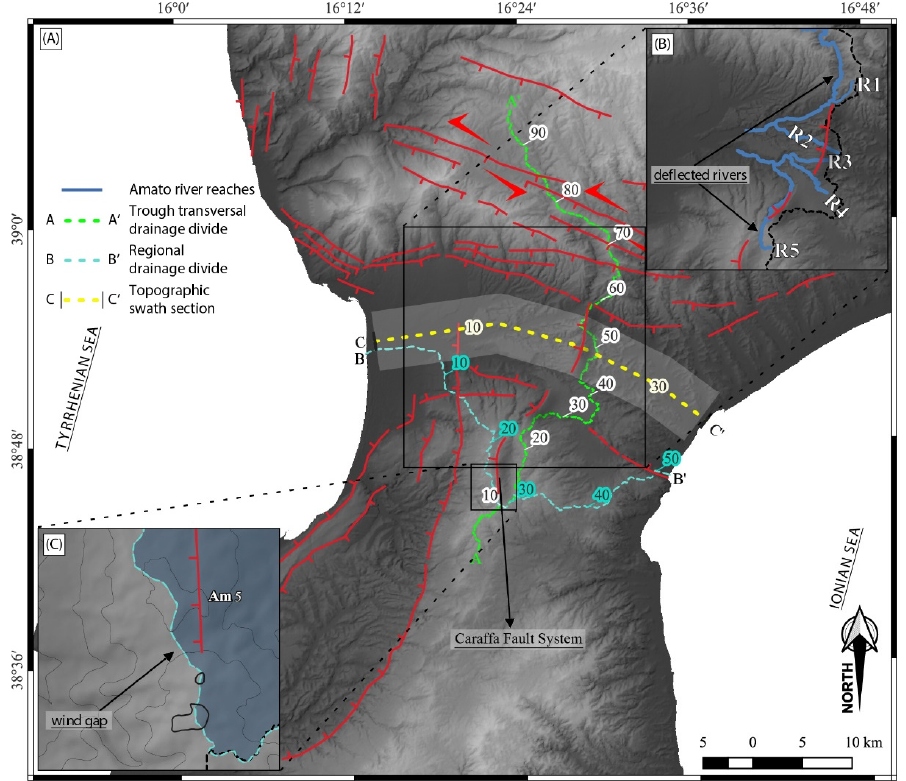
Figure 3. ( A ) Hillshade visualization of the Digital Elevation Model (DEM) of Central Calabria. The green dashed line A-A’ indicates the trace of the drainage divide transversal to the Catanzaro Trough (the profile is plotted in Figure 4A); the cyan dashed line B-B’ is the trace of the regional drainage divide crossing out the Catanzaro Trough (the profile is plotted in Figure 4B). The yellow dashed line C-C’ and the semi-transparent white polygon represent the baseline and area sampled by the topographic swath profile plotted in Figure 4C. Numbers indicate the along-trace distance expressed in km. ( B ) Map view of the main reaches of the Amato River crossed out or deflected by the Caraffa Fault System; the profiles of the reaches R1–R5 are plotted in Figure 5A–E. ( C ) Map view of a significant wind gap along trace B-B’ (see also Figure 4B).